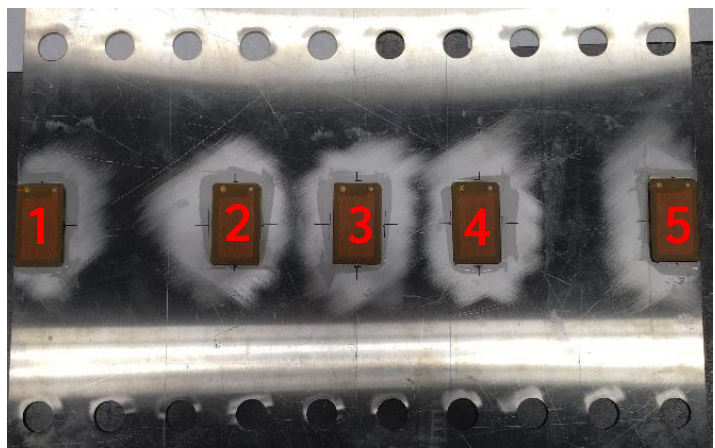
Figure 2. Piezoelectric actuator patches bonded to flat plate.